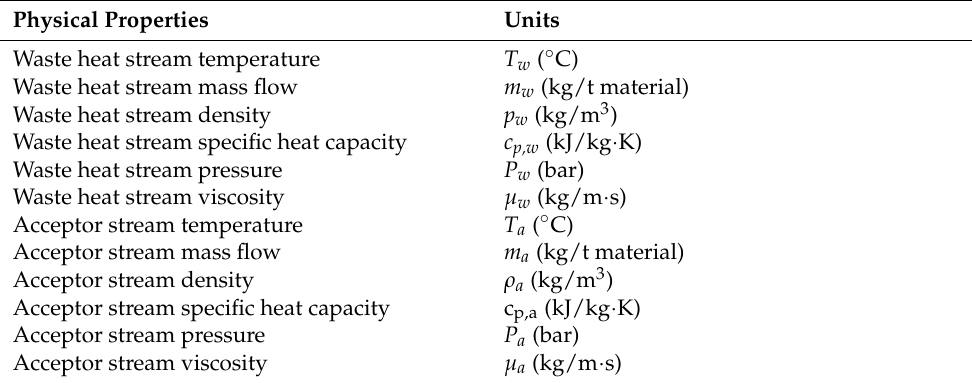
Table 2. Waste heat and acceptor stream physical properties.